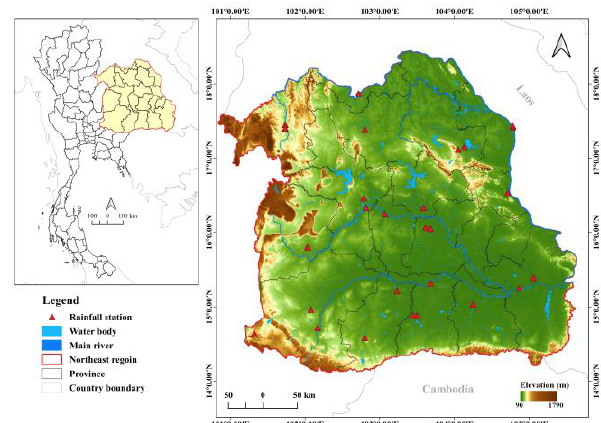
Figure 2. Study region (Northeast Thailand): background shows elevation with a height of 90-1,790 mm. The red triangle points are the rainfall stations of the Thai Meteorological